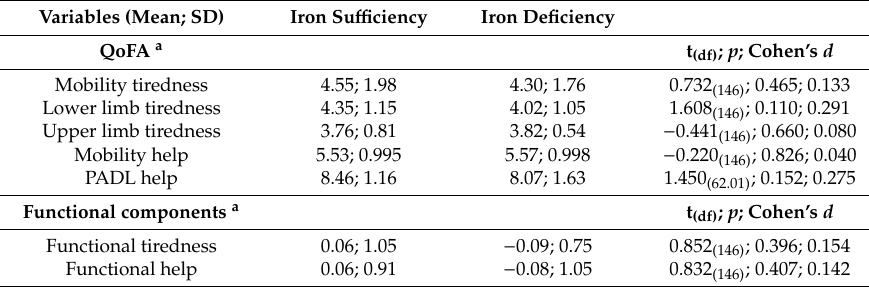
Table A2. Physical functional ability characterization of participants and di ff erences by group of iron